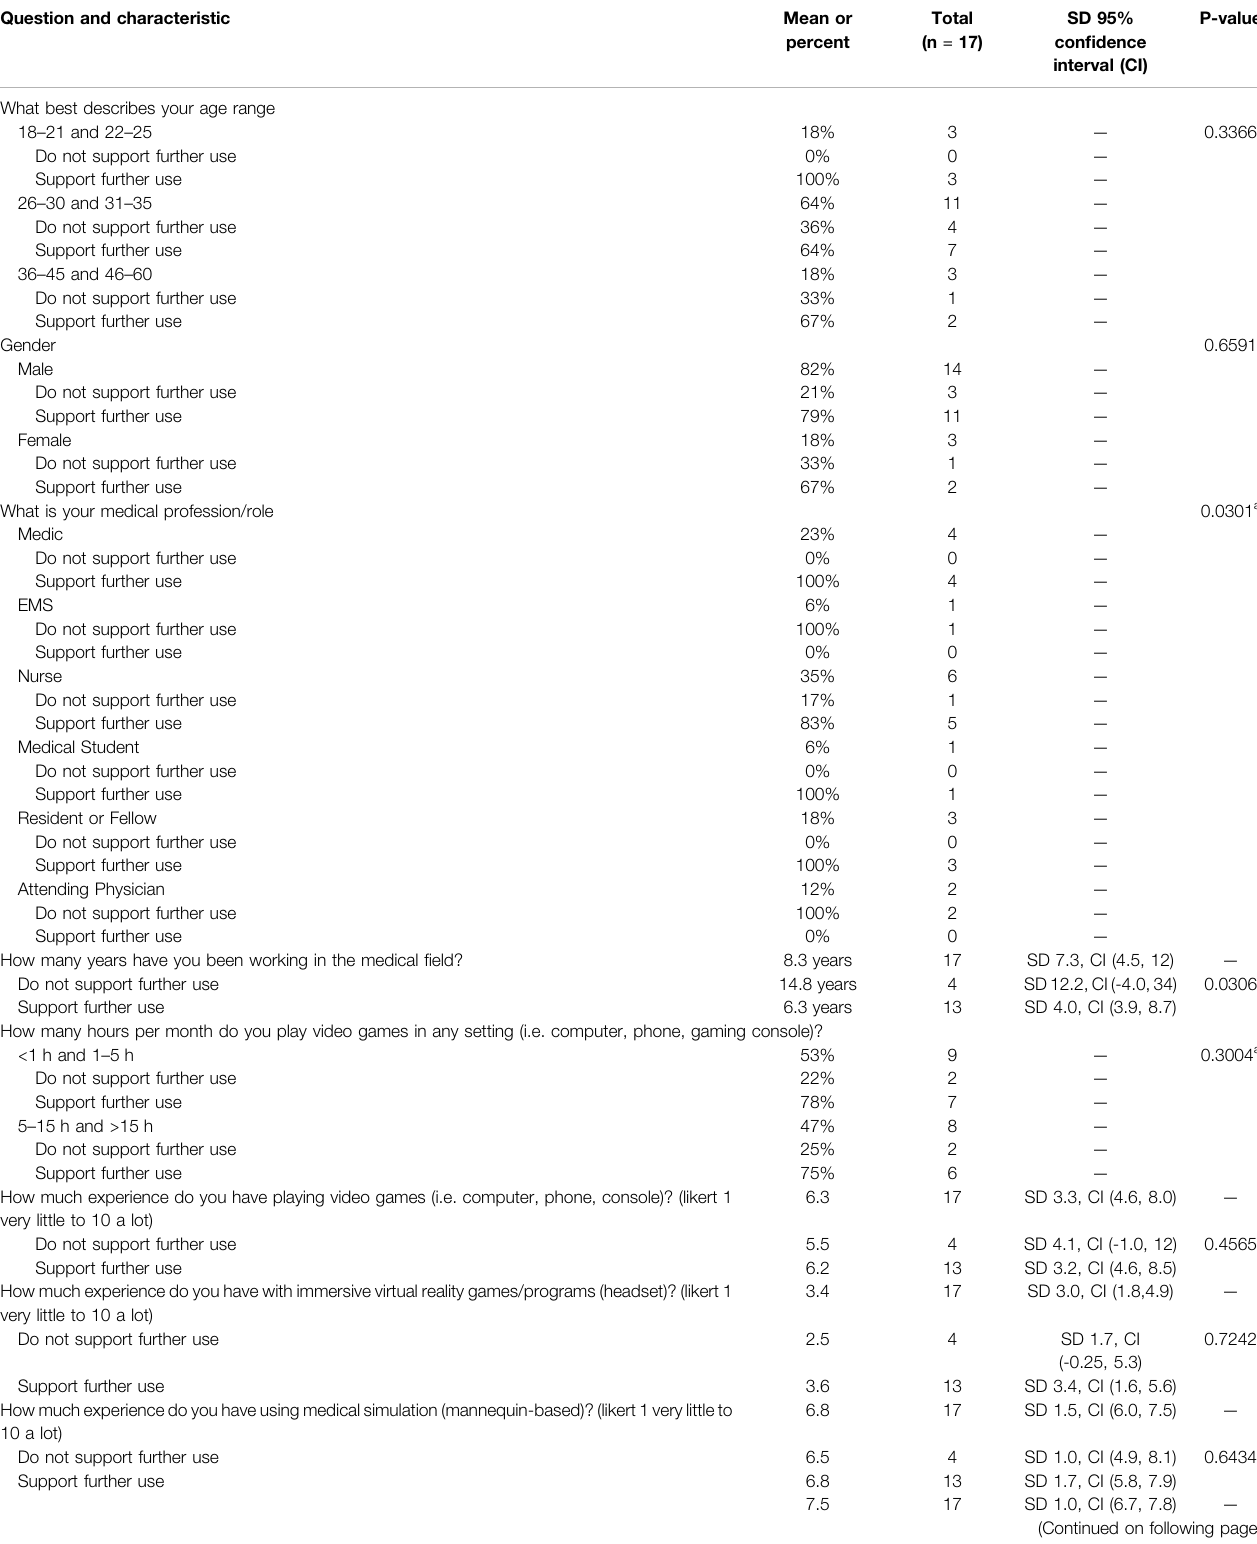
TABLE 3 | Results and data analysis. The analysis evaluates responses for statistically different characteristics in participants that answered “ I would support further use of thistechnologyinmytraining ” greaterthan8ona1 – 10likertversuslessthan8.Greaterthan8wasassociatedwith(Isupportfurtheruse)andlessthan8wasassociated with (I do not support further